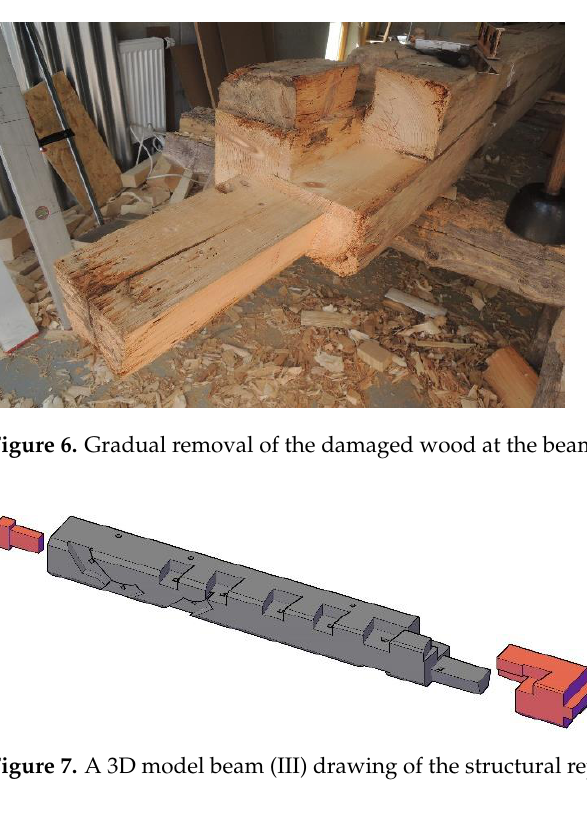
Figure 7. A 3D model beam (III) drawing of the structural repair of the damaged beam.